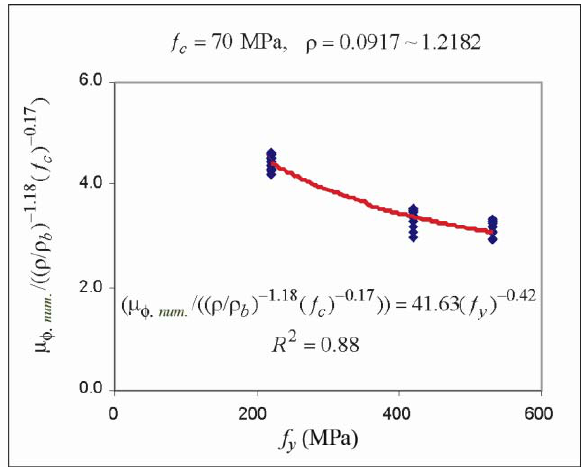
Fig. 4. Influence of y f on the ratio of curvature ductility to